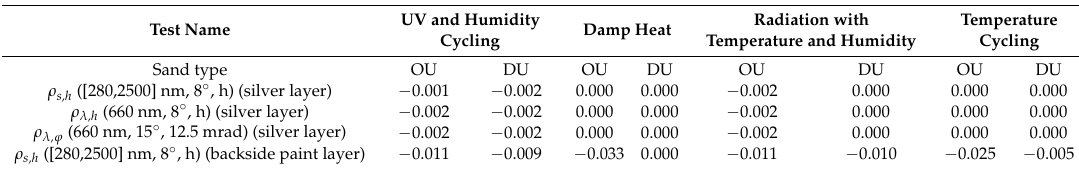
Table 2. Results of reflectance differences from all samples, after the preliminary weathering tests. OU: Ouarzazate; DU: Dubai.